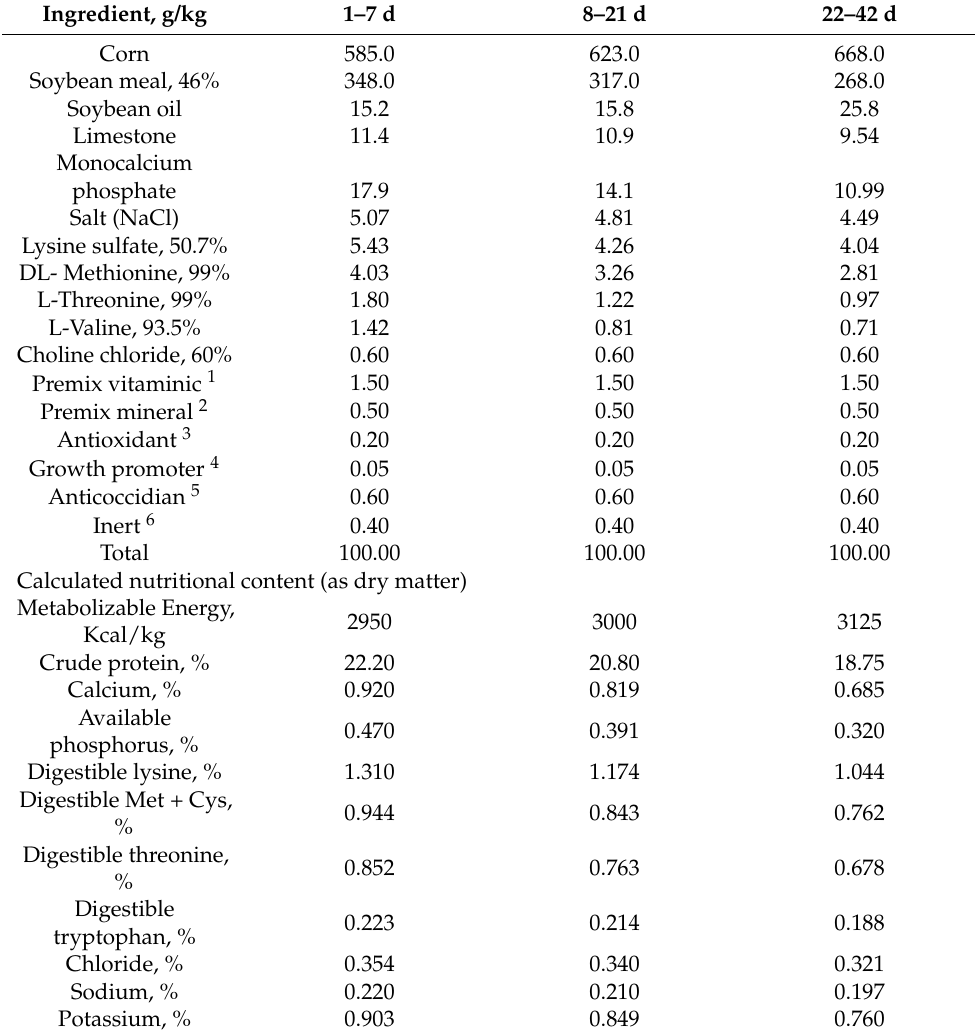
Table 1. Composition of the experimental diets (1–7, 8–21, and 22–42 days (d) of